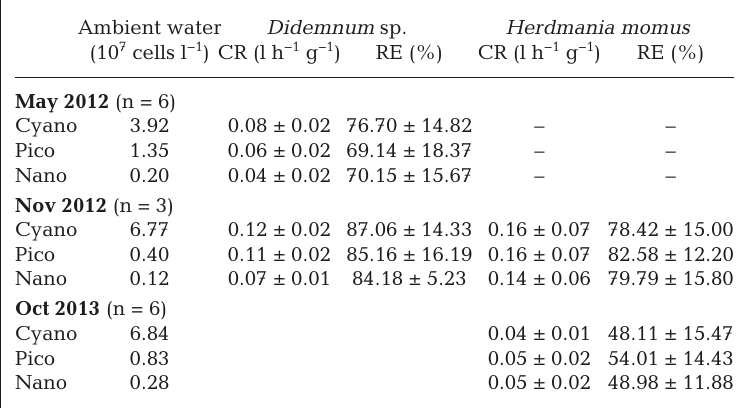
Table 5. Phytoplankton concentration in ambient water and ascidian filtration in Mangareva. Clearance rate (CR) and retention efficiency (RE) for the different sampling dates are given as mean ± SD. Cyano: cyanobacteria (size <3 µm); Pico: picophytoplankton (size <3 µm), Nano: nanophytoplankton (3−20 µm). –: not applicable; species not present on